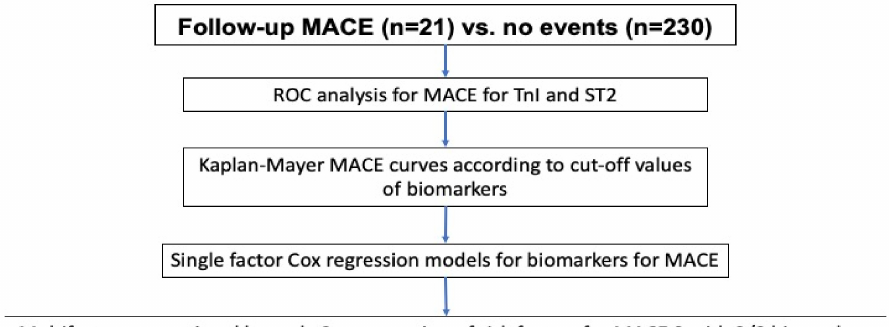
Figure 2. Mathematical model of the statistical analyses. ROC—receiver operator characteristics, sST-2—soluble suppression of tumorigenicity 2, hs-TnI—high sensitive troponin